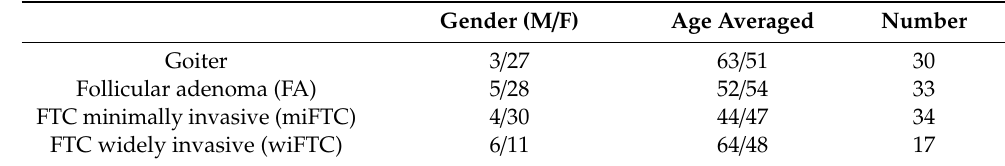
Table 4. Patients included in the